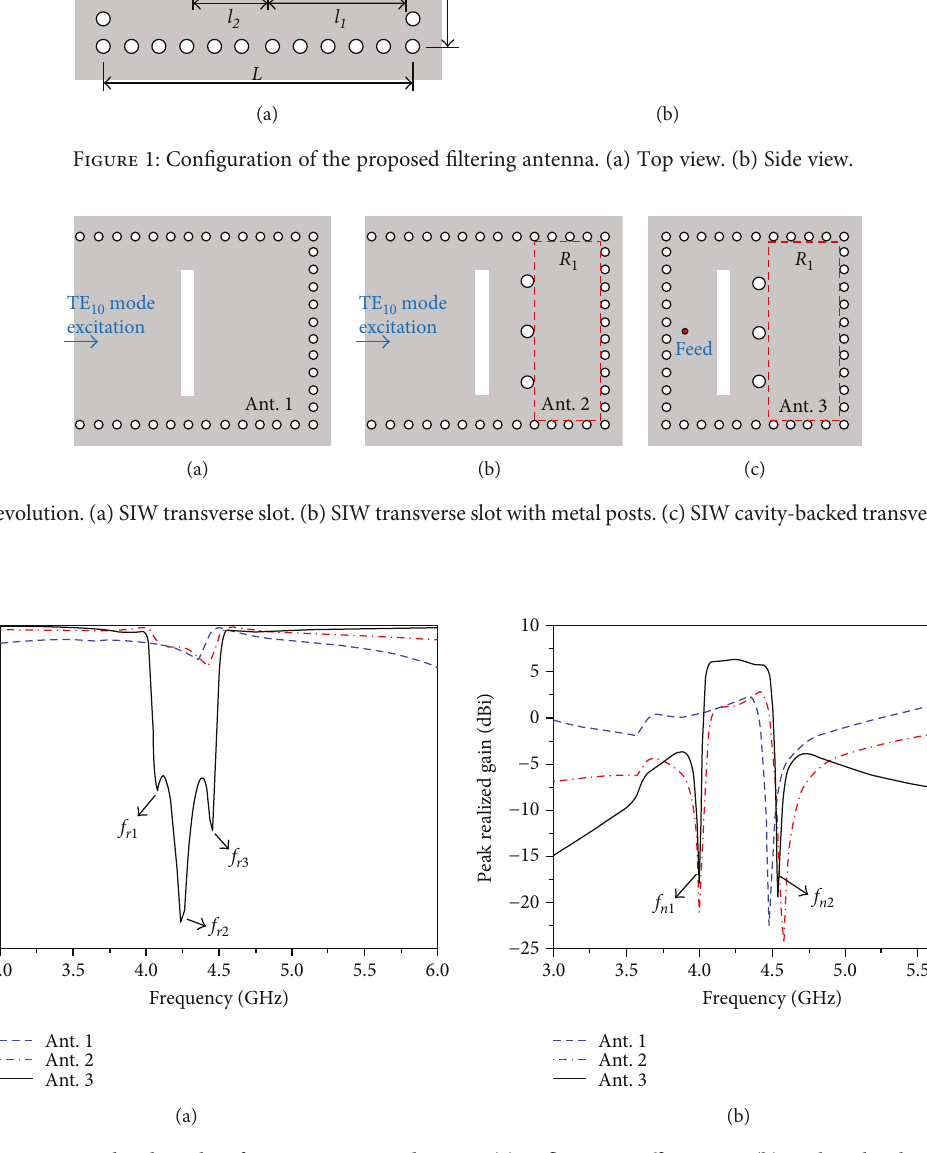
. (b) Peak realized gain. 11